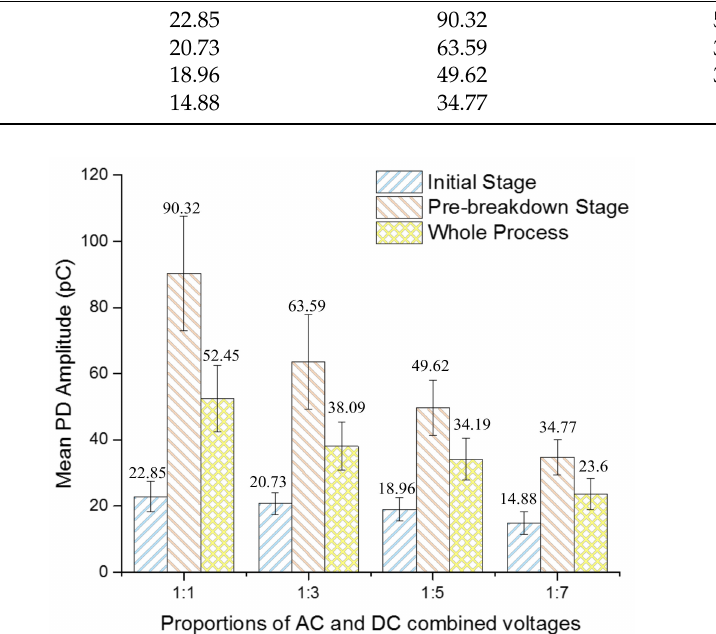
Figure 16. Relationship between mean PD amplitude and AC/DC